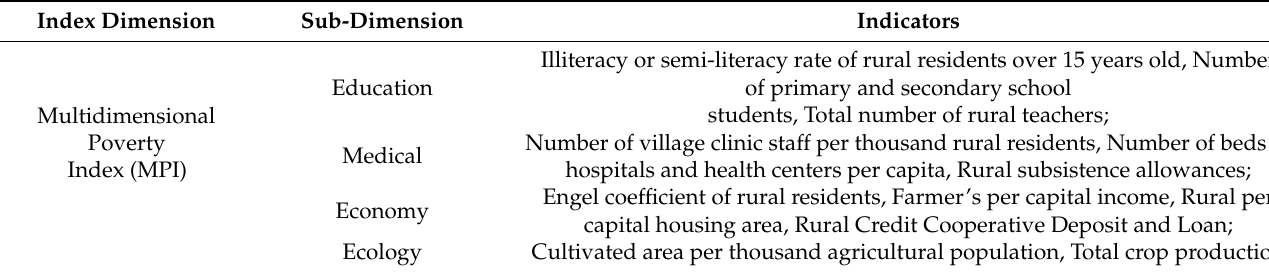
Figure 2. Study area. Table 1. Indicator system for assessment of